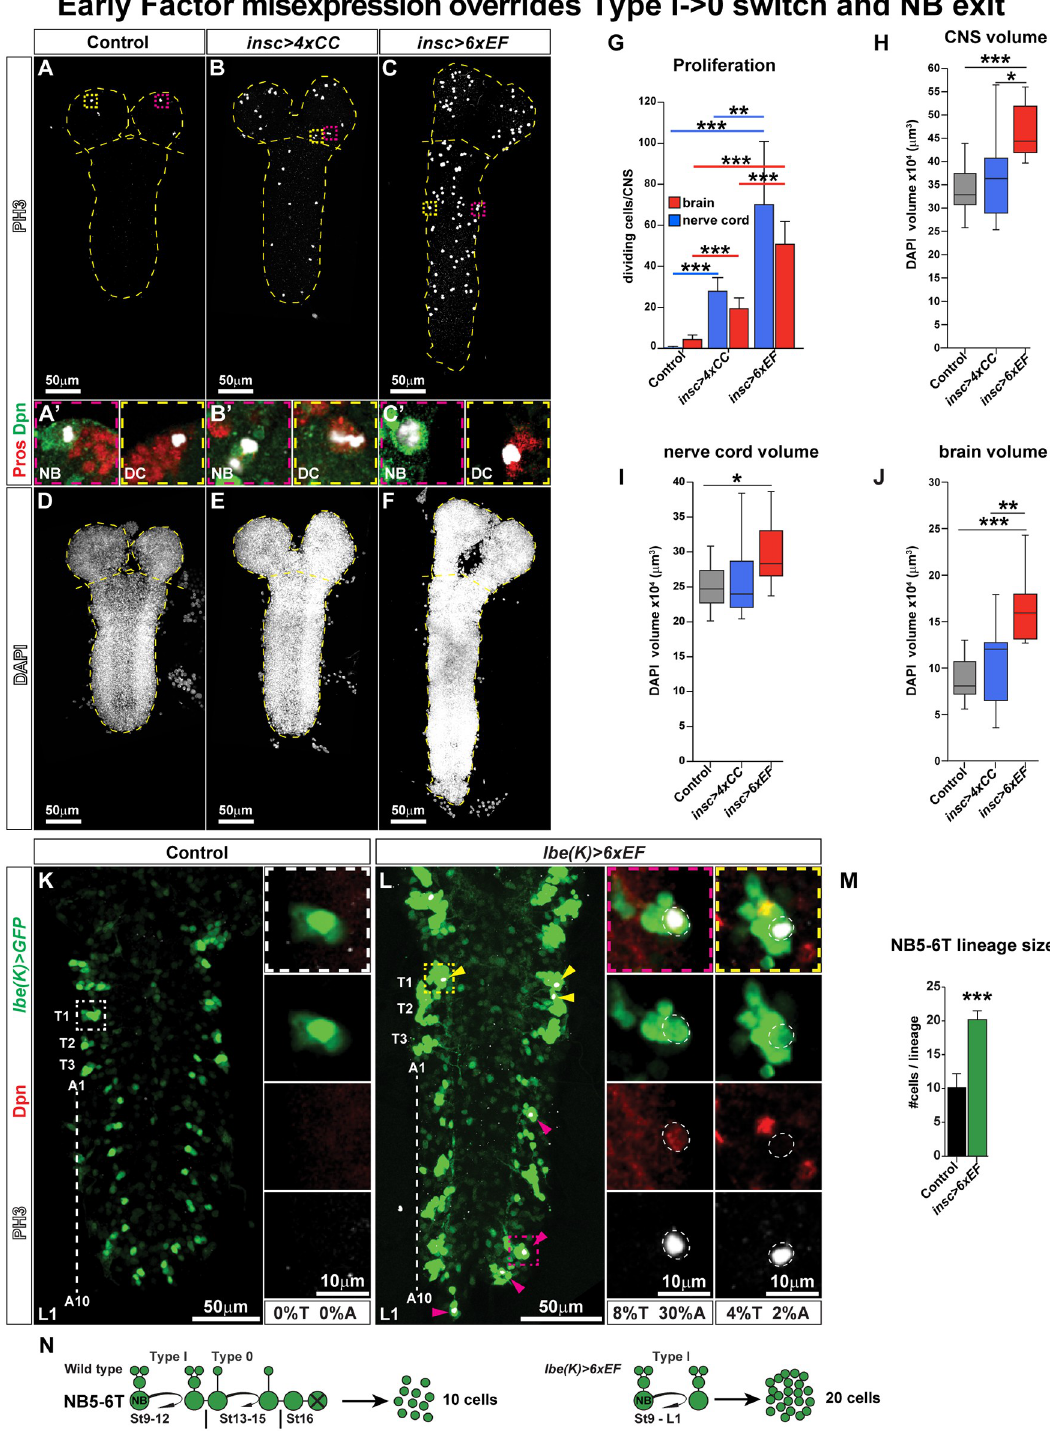
Fig 2. EF co-misexpression overrides the Type I- > 0 switch and NB exit. (A–F) Whole CNS, AFT stage, stained for PH3 (A–C) or DAPI (D–F). (A) In control, a small number of dividing cells is observed in the brain and an occasional division in the nerve cord. (B) In insc-Gal4/UAS-4xCC , aberrant cell divisions are observed in both the brain and nerve cord. (C) In insc-Gal4/UAS-6xEF , aberrant divisions are even more frequent. (A 0 –C 0 ) Close-up of dividing NBs and daughter cells, identified by PH3, Dpn, and Pros. (G) Quantification of proliferation in the brain and nerve cord. Both UAS-4xCC and UAS-6xEF CNSs show significantly